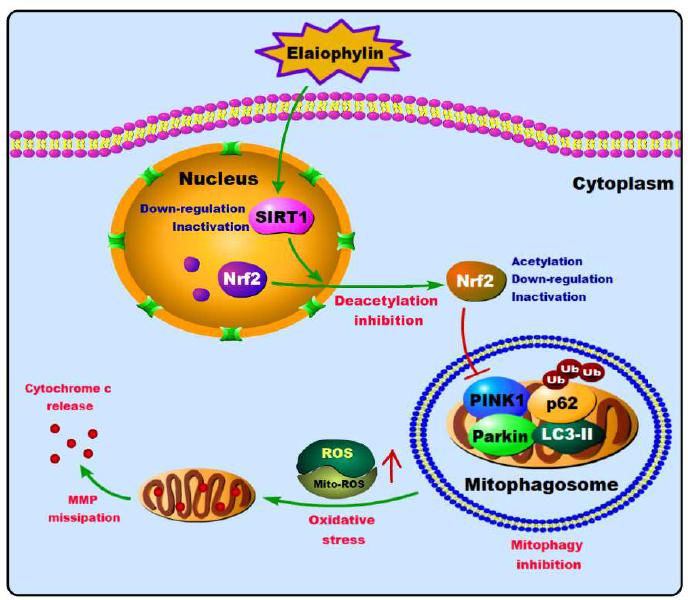
Figure 9. The proposed molecular mechanism of elaiophylin on human lung adenocarcinoma cells.